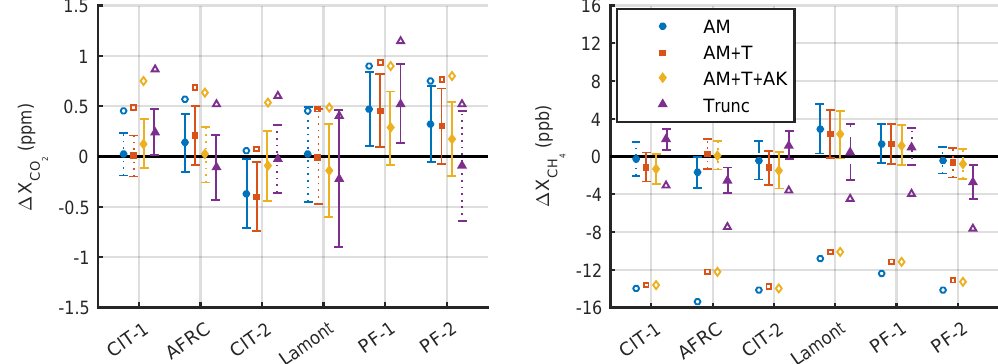
Figure 9. Medians and standard deviations of the TCCON data compared to the mFTS product after various adjustments. Line style represents the significance of the difference of the group median from the median of all data by the Kruskal–Wallis test ( p <0.05 - , p <0.2 - -, otherwise ... ). Legend entries indicate what adjustments were applied to the data to make measurements from the different instrument types more comparable. Open symbols did not have a scaling factor applied to center about zero. AM is air mass adjustment; T is temperature error adjustment; AK is averaging kernel